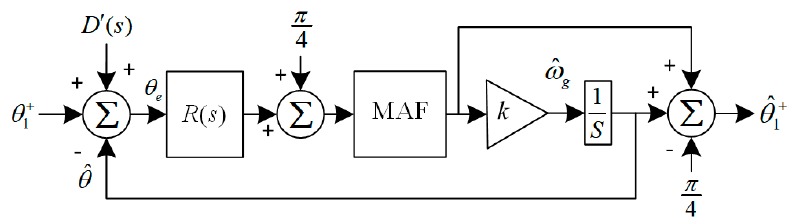
Figure 12. Mathematics model of the proposed PLL.